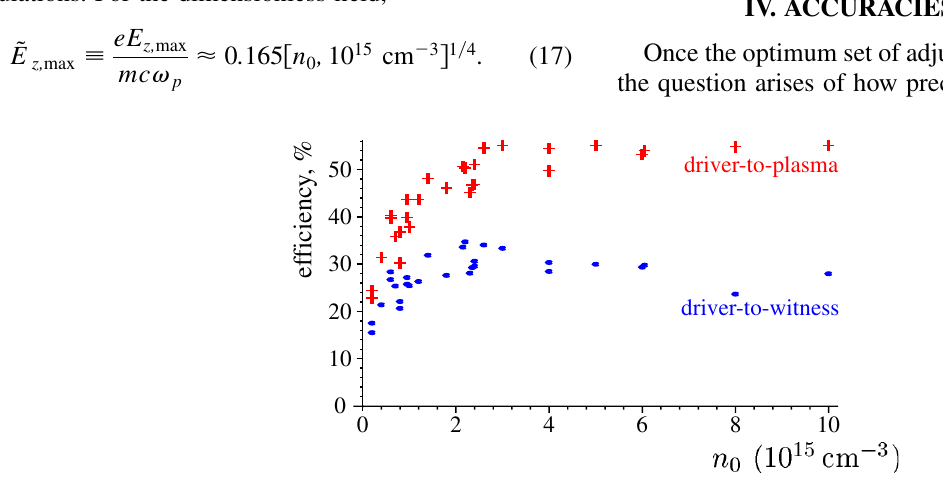
FIG. 7. (Color) Efficiency of driver-to-plasma (crosses) and driver-to-witness (ovals) energy